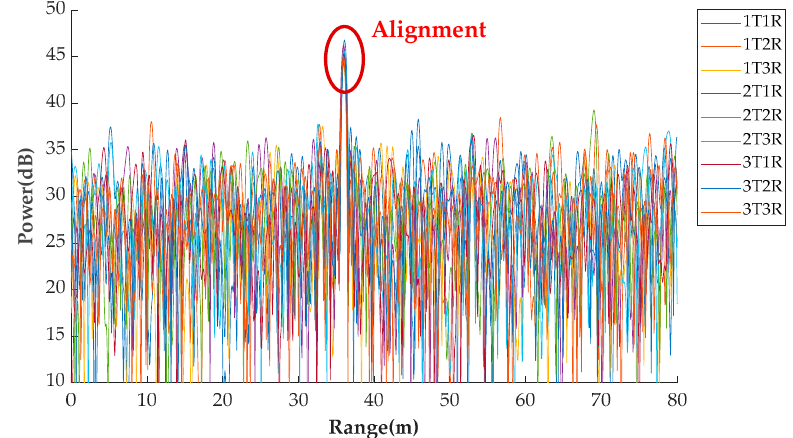
Figure 13. The range spectra of the original beat signal in multi-channel. ( a – i ) are the channels 1T1R to 3T3R, respectively.